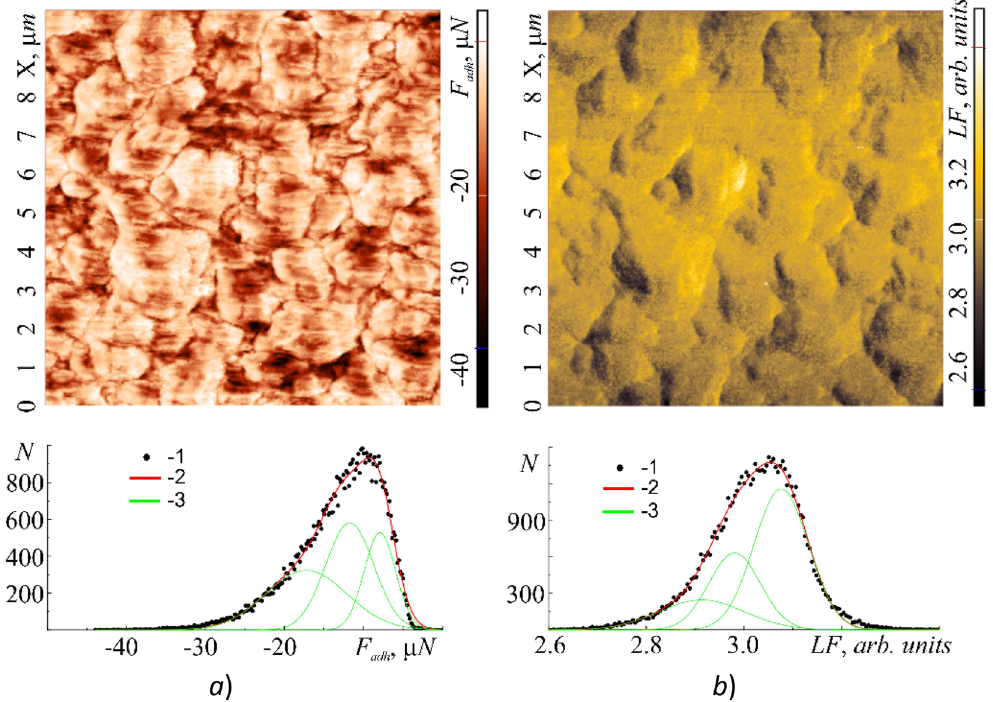
Figure 8. Topographic images of a 10 × 10 μm section of the cell wall surface obtained in the hybrid AFM mode at a resolution of 100 × 100 scanning points: adhesive F adh = F adh ( x , y ) ( a ) and lateral F L = F L ( x , y ) ( LF -contrast) ( b ) with their histograms N = N ( F adh ) and N = N ( LF ≡ F L )—(2) respectively. Points (1)—experiment, curves (3)— approximation by Gaussian